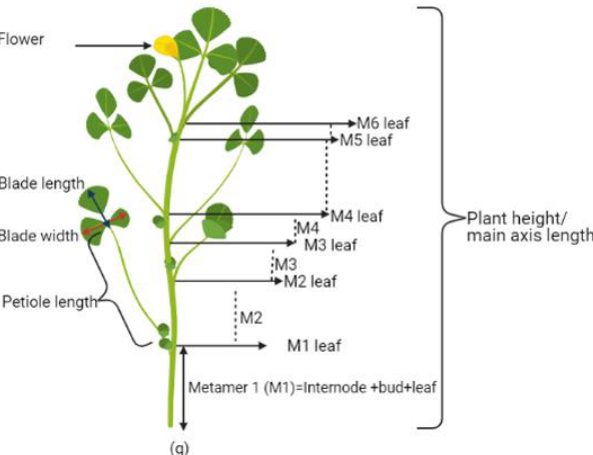
Figure 5. Effect of algae application on the leaf size of 50-day-old Medicago truncatula leaves; 10 replicates were measured per experiment. ( a ) Leaf petiole; ( b ) petiole length relative to control; ( c ) leaf blade length; ( d ) leaf blade length relative to control; ( e ) leaf blade width; ( f ) leaf blade width relative to control; ( g ) Illustrative diagram of M. truncatula, created with BioRender.com, showing the different phenotypic parameters that were measured. Metamers (internode, leaf and bud) and their associated leaves are labelled from the bottom to the top along the main axis in ascending order. The red arrow on the first leaf depicts blade width, the dark blue arrow depicts blade length and the brackets show the petiole length. Different letters on the bars indicate significant differences between groups ( p < 0.05) according to Tukey’s multiple comparison test. Two-way ANOVA was used for all parameters.